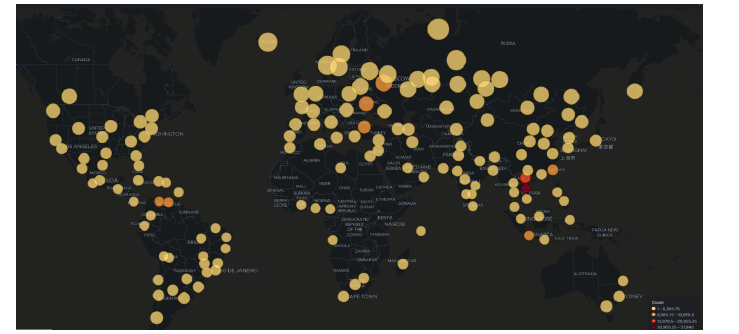
Figure 2. AWS Honeypot Attack